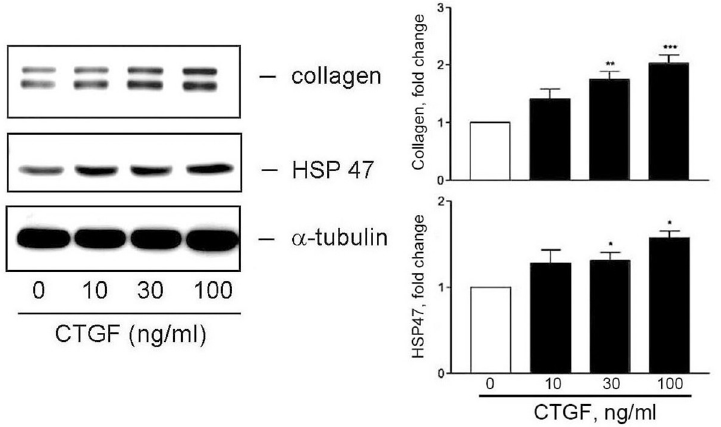
Fig 4. CTGF enhances collagen and HSP47 expression in HESCs. Human CTGF was added to cells for 16 h. The cells were collected and collagen and HSP47 expression were analyzed through Western blotting (n = 3). � P < 0.05, �� P < 0.01, and ��� P < 0.001 versus vehicle treatment only (CTGF 0 ng/ml).